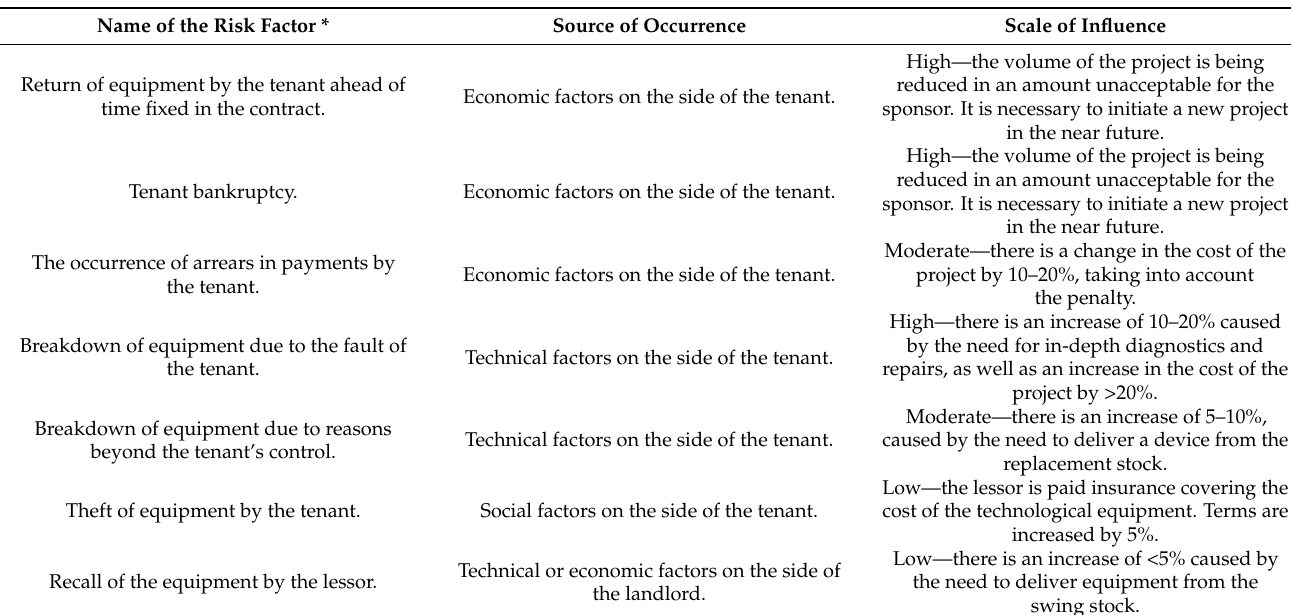
Table 1. Compensation systems